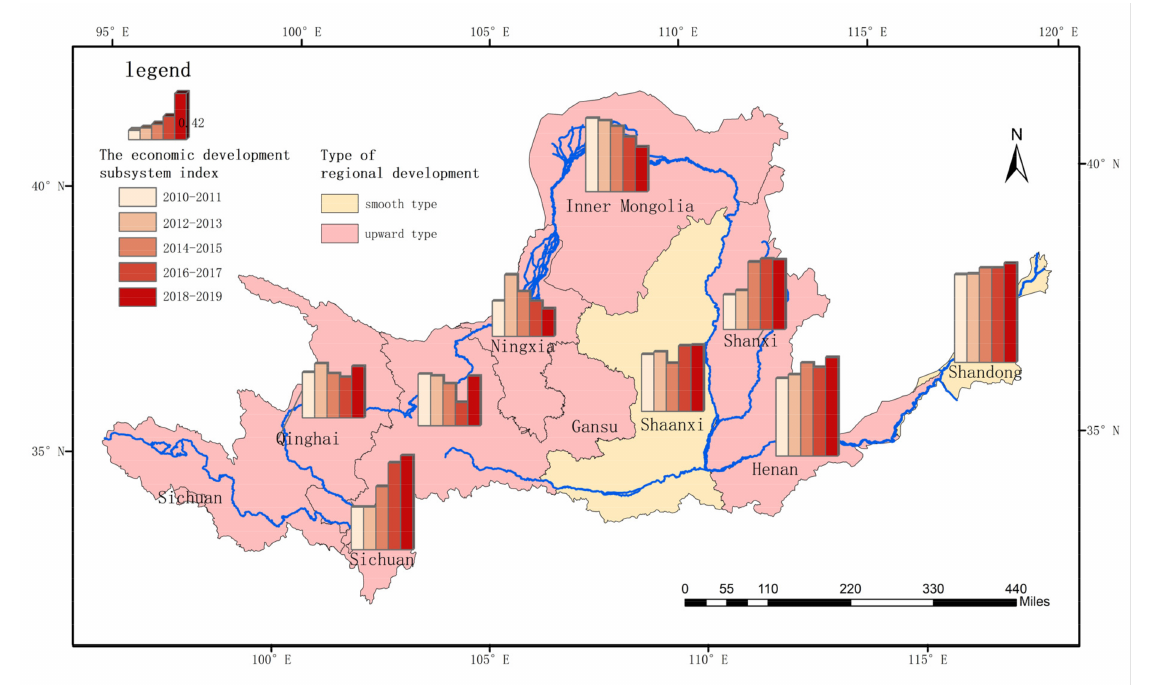
Figure 6. Evaluation of the ecological situation in the provinces in the Yellow River basin during 2010–2019.